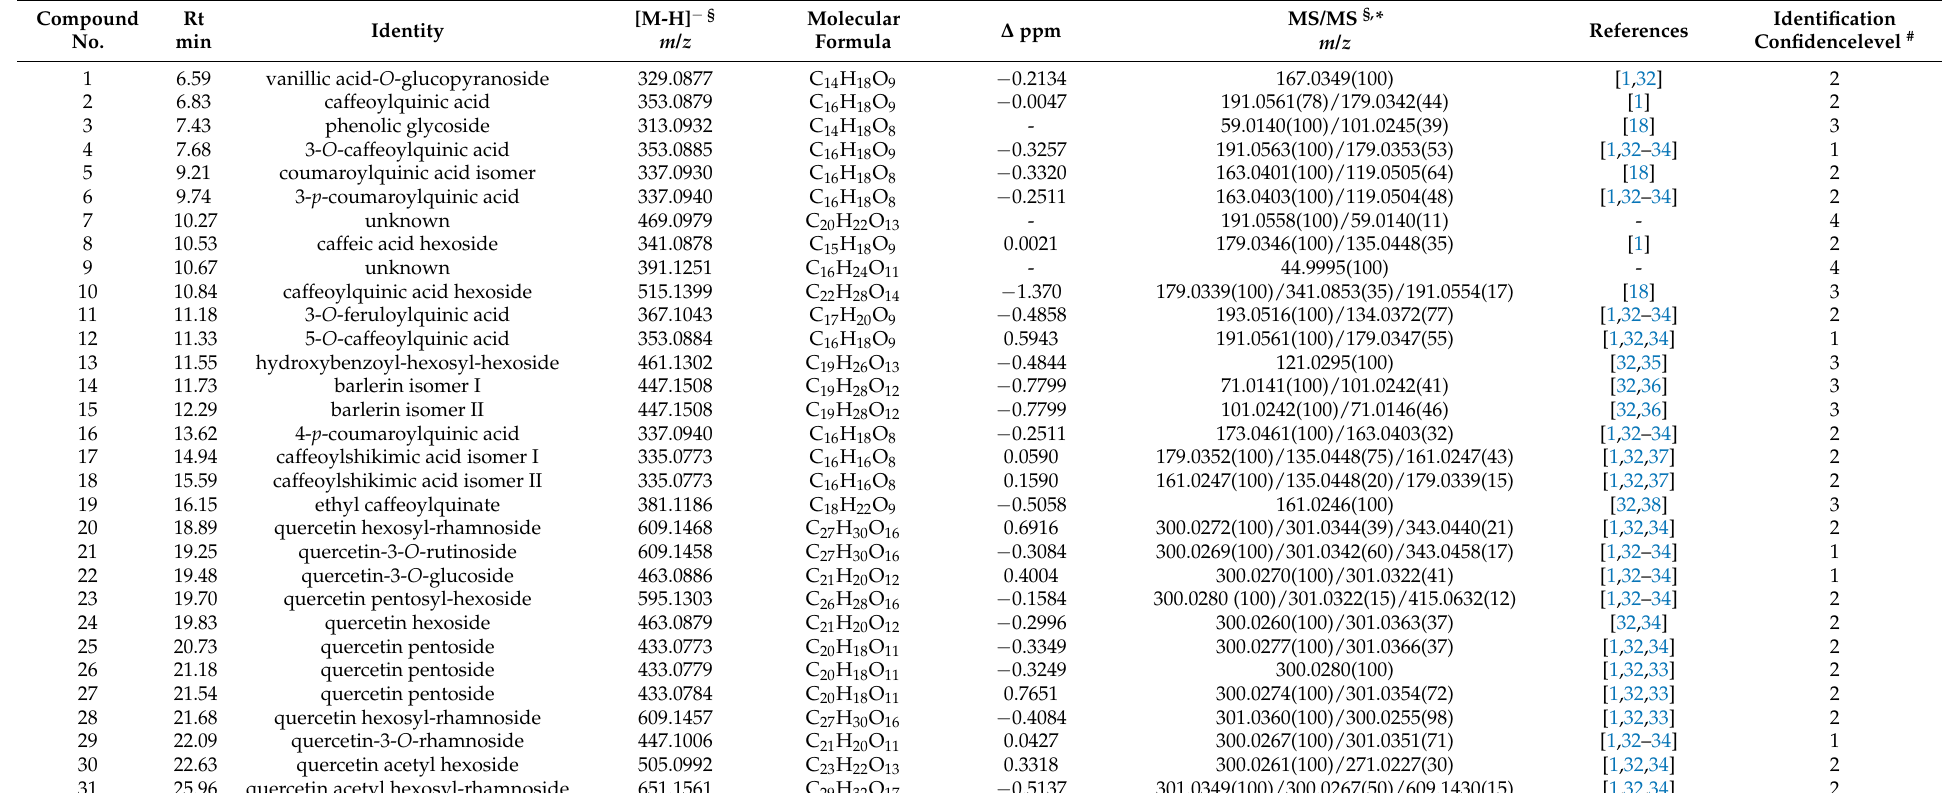
Table 2. Compounds identification by (HR) LC-ESI-QTOF MS/MS in P. spinosa fruit extract. Compound